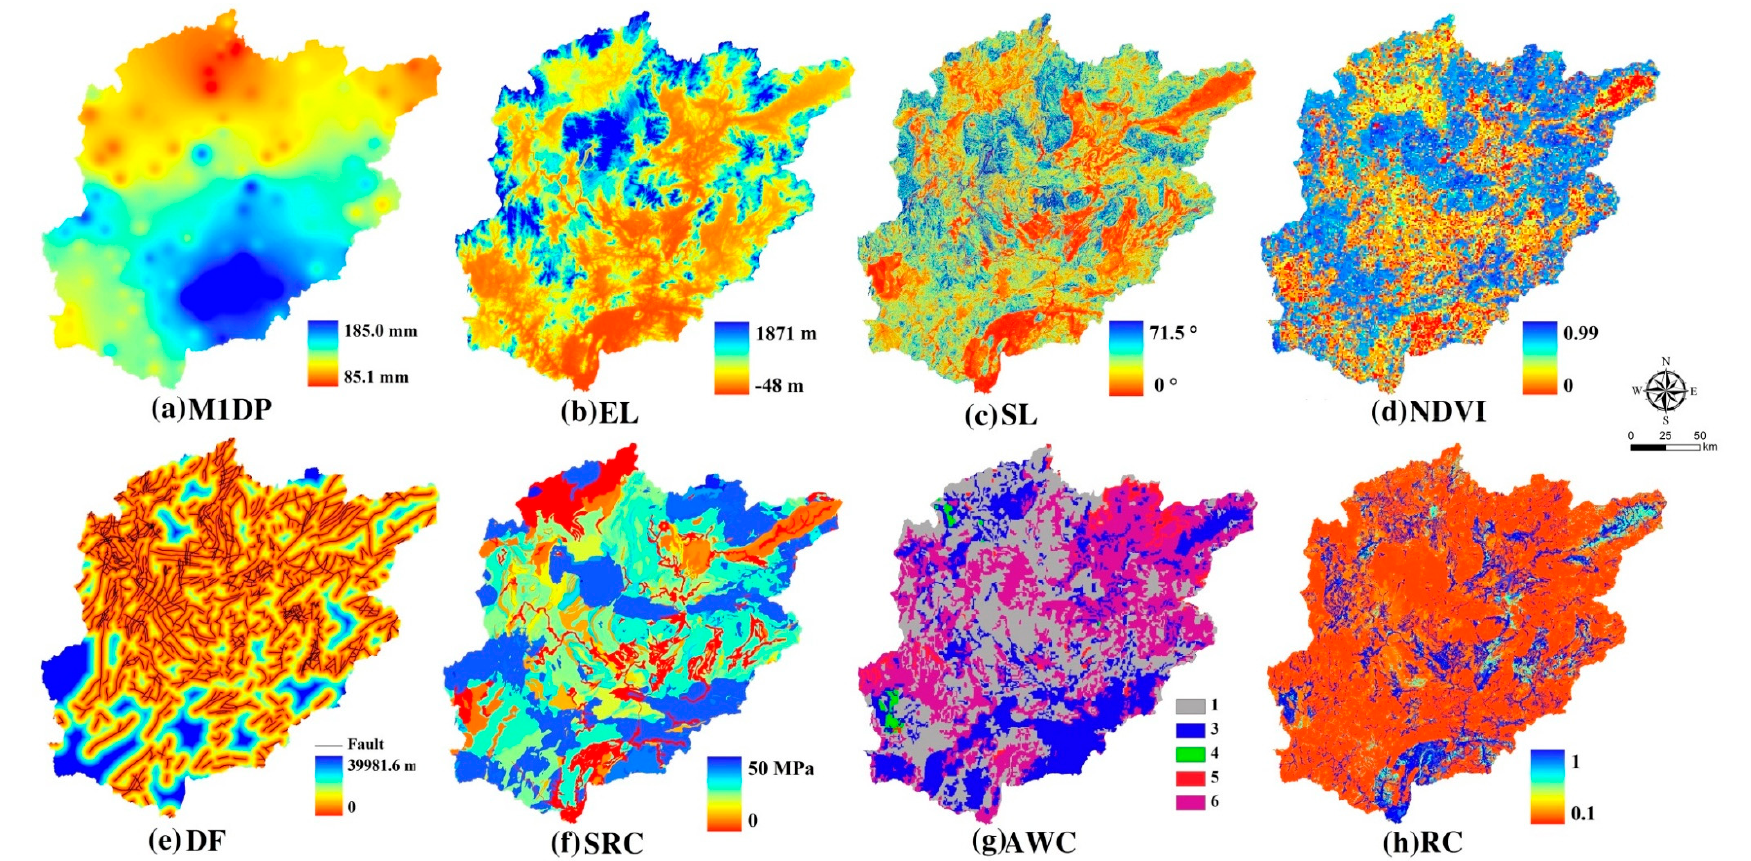
Figure 4. Spatial distribution characteristics of the eight susceptibility indices. Note: M1DP—maximum one-day precipitation; EL—elevation; SL—slope angle; NDVI—normalized difference vegetation index; DF—distance to fault; SRC—shear resistance capacity; AWC—available water storage capacity; RC—runoff coefficient.